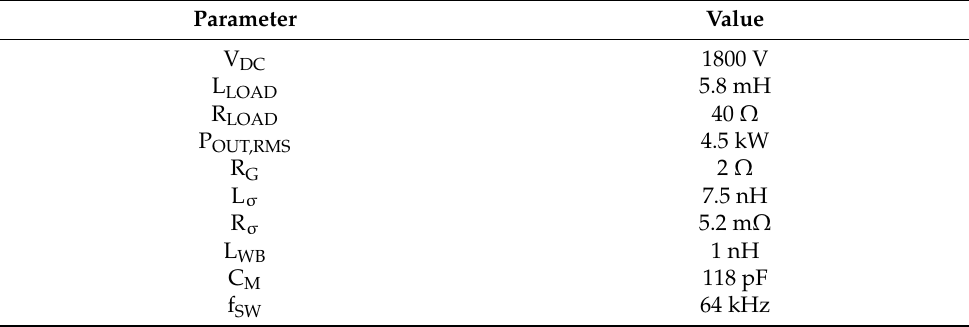
Figure 11. Schematic of the half-bridge circuit driven in a single-phase inverter configuration. Evidenced are the experimentally-extracted parasitics (red), the output current and voltage (orange and green arrow, respectively), the VDMOS subcircuits described in Figure 3 (light green boxes), the current sensing component (orange), the ICU (turquoise), and the logic signals (grey dashed lines) fed to the gate drivers of the four transistors. Table 4. Values of the inverter parameters adopted in